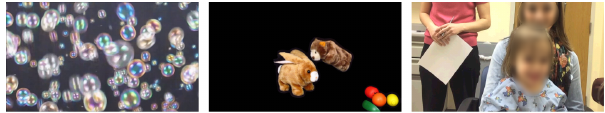
Figure 1: Example images of the experimental setup. From left to right, the first two images show screenshots from the two video-stimuli. The right-most image is an example of the recording acquired from the front camera on the